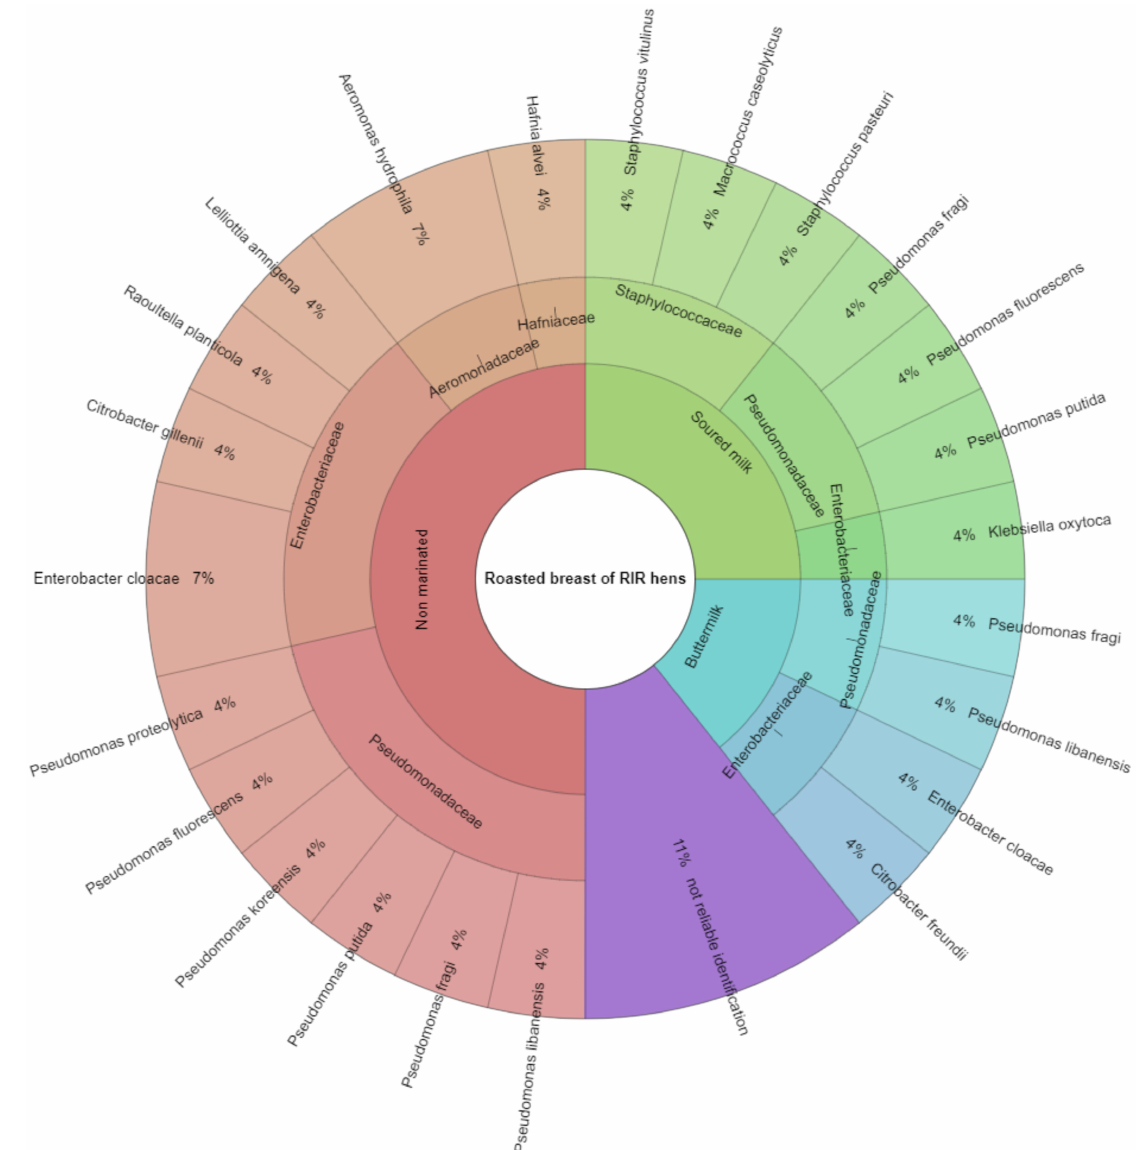
Figure 2. Bacteria identified in samples of roasted meat from RIR hen breast